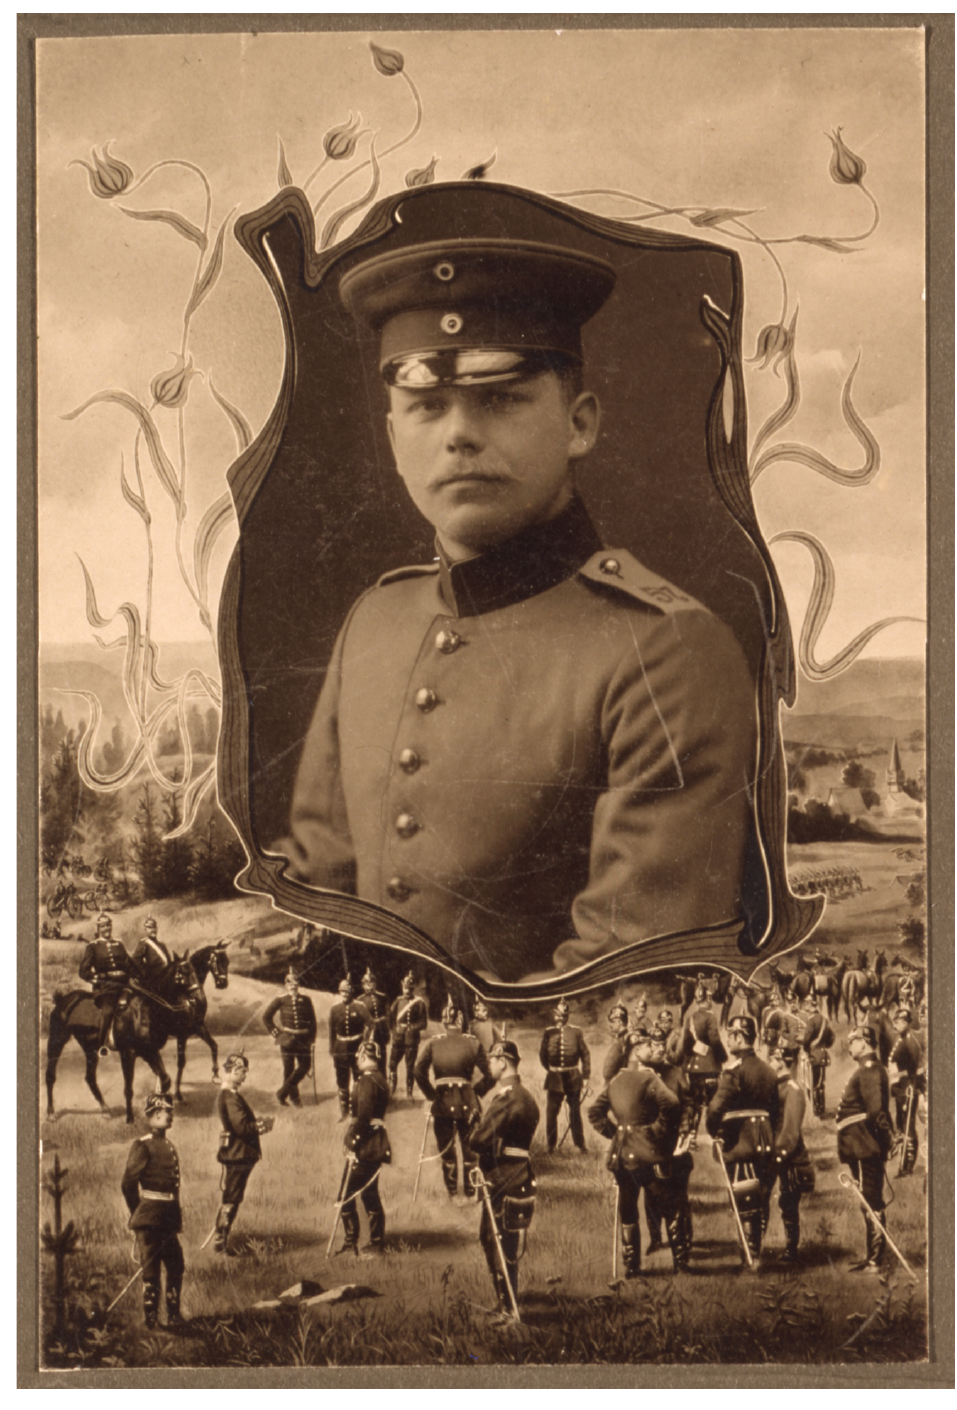
Figure 4 Unknown photographer, portrait of a soldier whose identity is also unknown. c. 1910. Single gelatin silver bromide photograph made from a montaged negative. Collection of the Museum Folkwang, Essen. 14.8 x 9.9